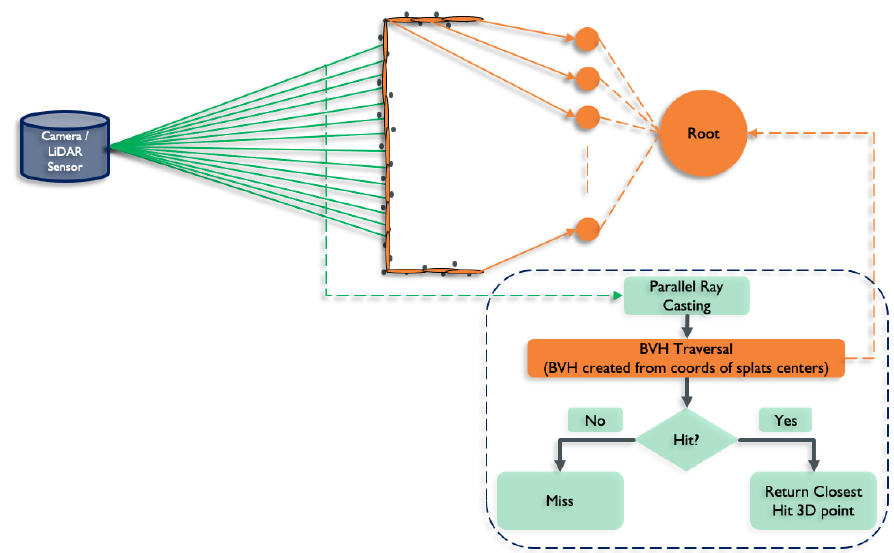
Figure 4. Parallel ray casting and accelerated ray–splat intersection are achieved using OptiX. The BVH is created from the splats primitives; then, the rays are cast in parallel on the device. Each ray traverses the BVH, and an intersection is reported back if a hit is found. Otherwise, the intersection for the specific ray is ignored.